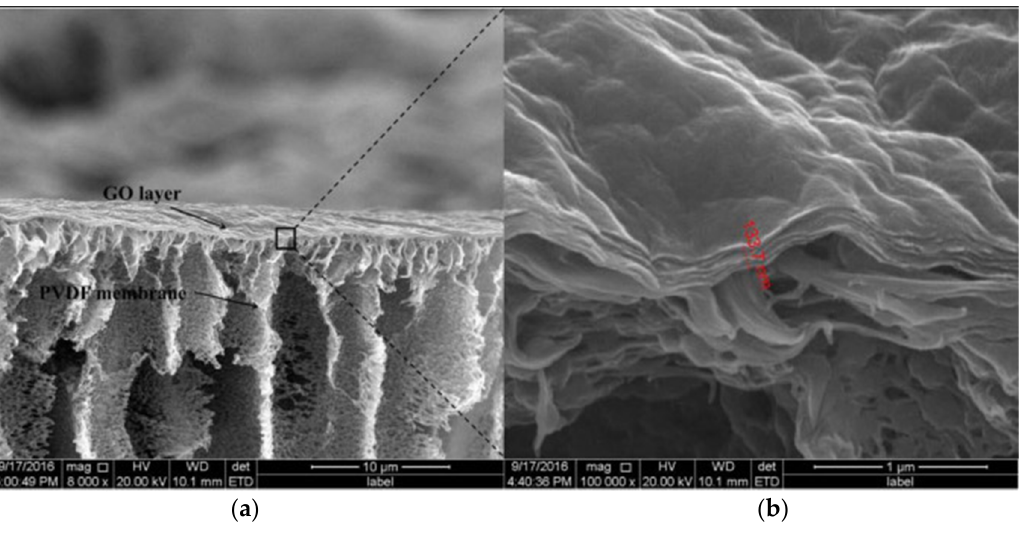
Figure 14. = SEM images of the GO membrane ( a,b ) [136].